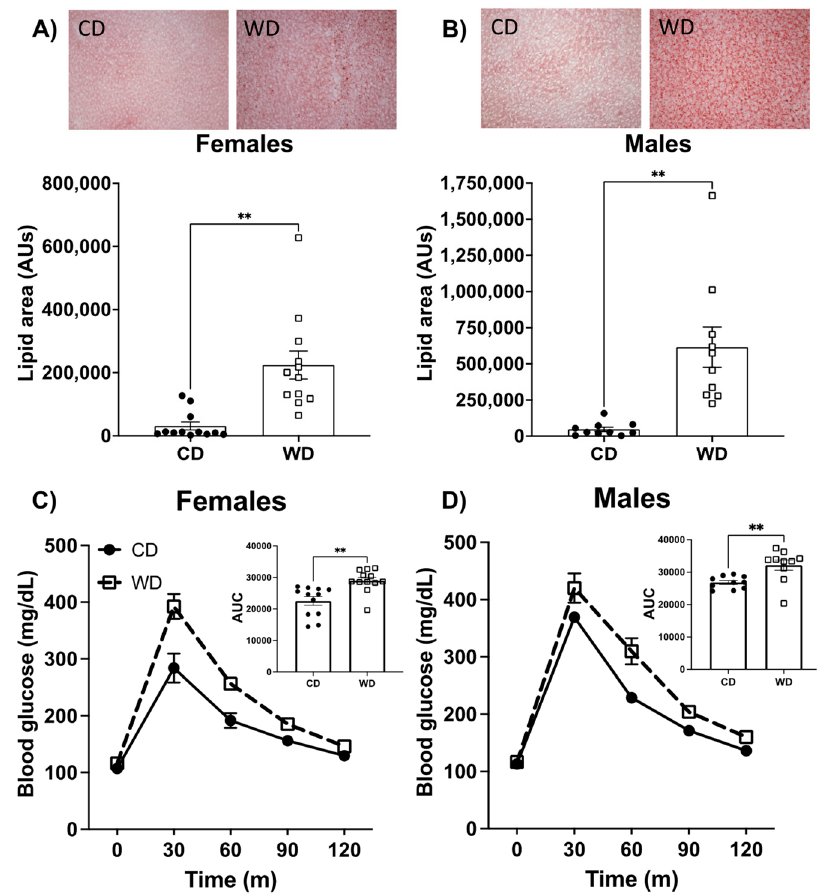
Figure 2. Representative images and quantification of liver fat in females ( A ) and males ( B ) fed either a Western diet (WD) or control diet (CD) using Oil Red O liver stain. Effect of a WD consumption for 5 weeks on blood glucose levels in an intraperitoneal glucose tolerance test in female ( C ) and male ( D ) rats with area under the curve (AUC) shown in each inset. Data are analyzed using a two-tailed Student’s t Test ** p < 0.01. Data are shown as the means ± SEM. AU= arbitrary units; mg/dL = milligrams/deciliter.